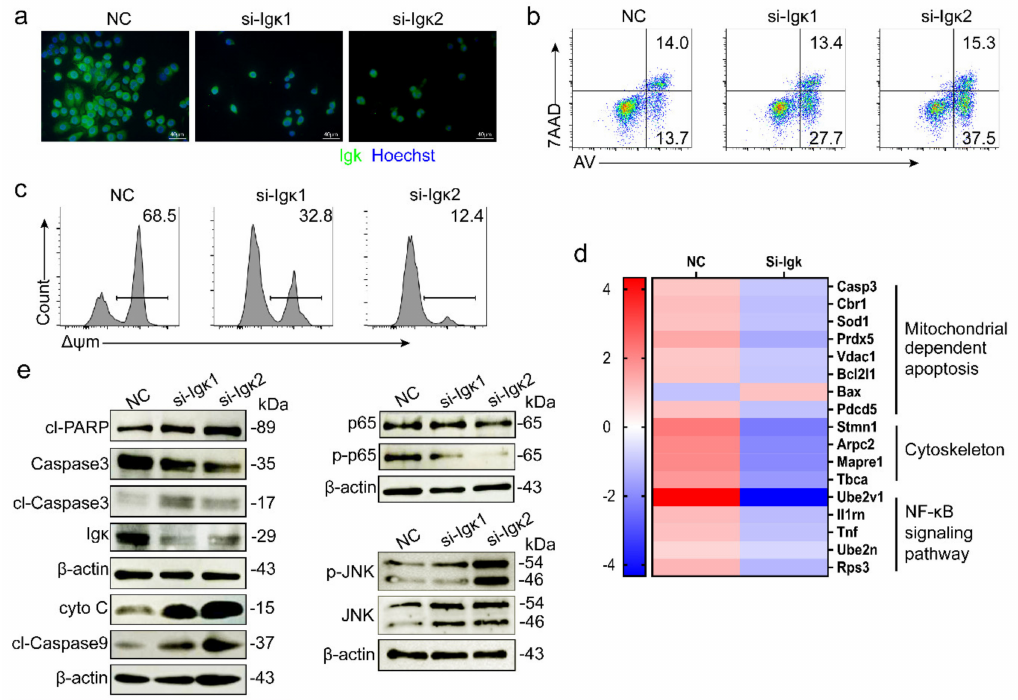
Figure 5. Knockout of Ig κ induced mitochondria-mediated apoptosis in the NCTC1469 cell line. NCTC1469 cells were transfected with si- Ig κ or control si-RNA (NC) for 24 h before analysis. ( a ) Bright-field images and immunofluorescence staining of Ig κ . ( b ) Ig κ knockout promoted NCTC1469 cell apoptosis on Annexin V and 7-AAD analysis. ( c ) Ig κ knockout in NCTC1469 cells reduced mitochondrial membrane potential. ( d ) Protein mass spectrometry analysis of NCTC1469